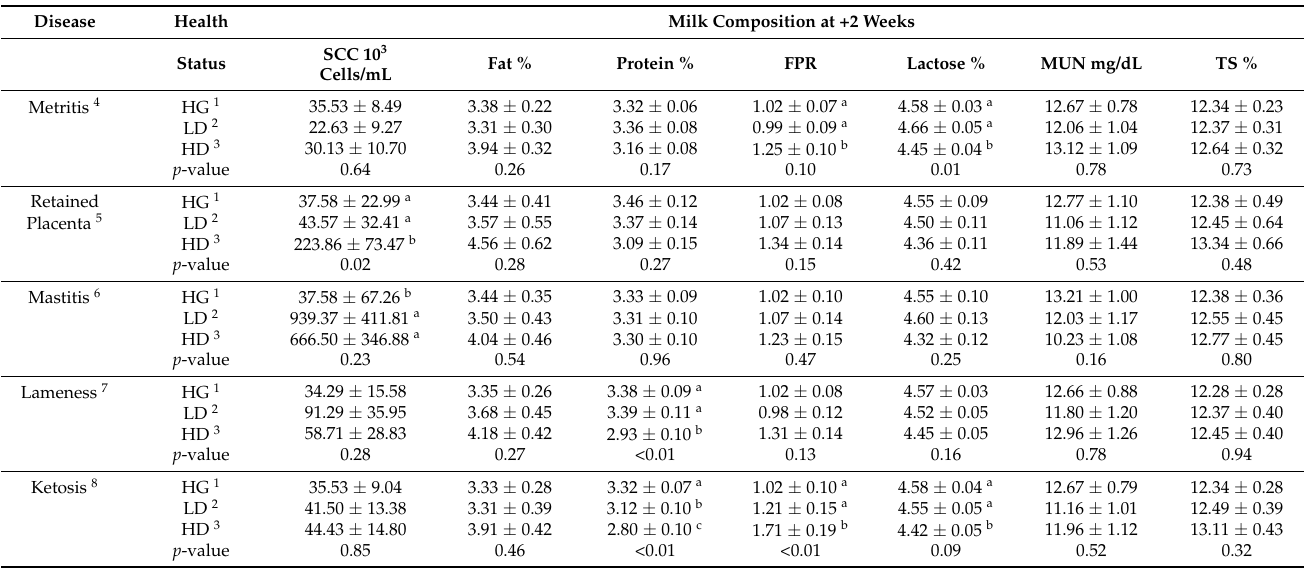
Table 5. Alterations in milk composition (fat, protein, fat:protein ratio, milk urea nitrogen (MUN), total solids (TS), and somatic cell counts (SCC)) at 2 weeks after parturition in dairy cows diagnosed with post-partum